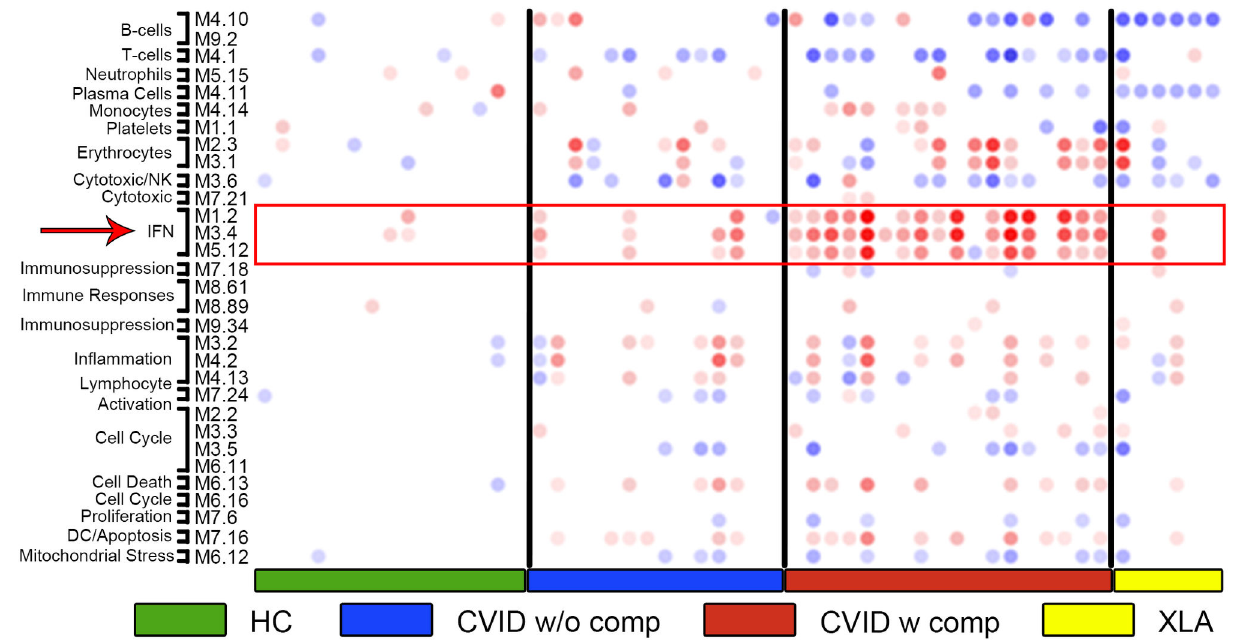
Figure 7. Modular analysis of differentially expressed transcripts in CVID. Whole blood modular signatures of CVID subjects in the test set identified significant down regulation of B-cell and T-cell modules and up-regulation of IFN-related modules, preferentially in CVID patients with inflammatory complications. Columns represent the profiles on individual patients and controls, healthy controls and XLA subjects. Spot intensity (red = increased, blue = decreased) indicates transcript abundance within each module as